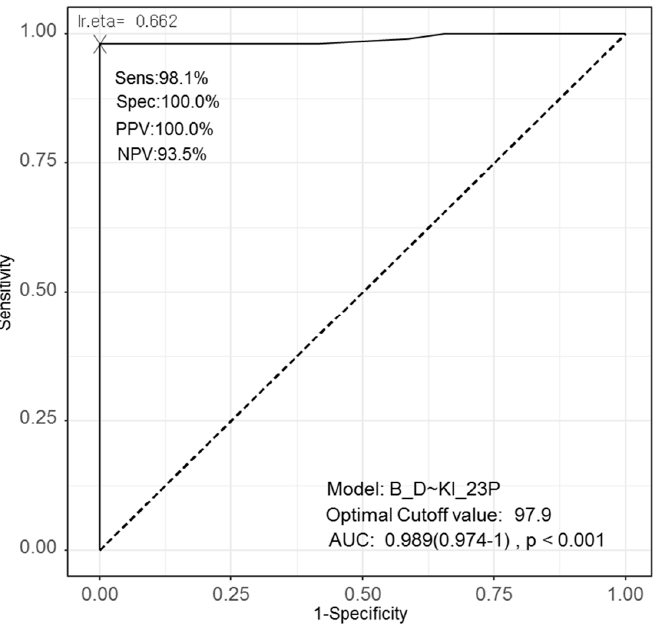
Figure 3. Receiver operating characteristic (ROC) curve using 2+ and 3+ cell proportions among positive cells, area under the curve (AUC), and the optimal cut-off value for differentiating Burkitt lymphomas (BLs) and diffuse large B-cell lymphomas (DLBCLs). Using the cut off value of 97.9%, the sensitivity is 98.1% and the specificity is 100.0%.